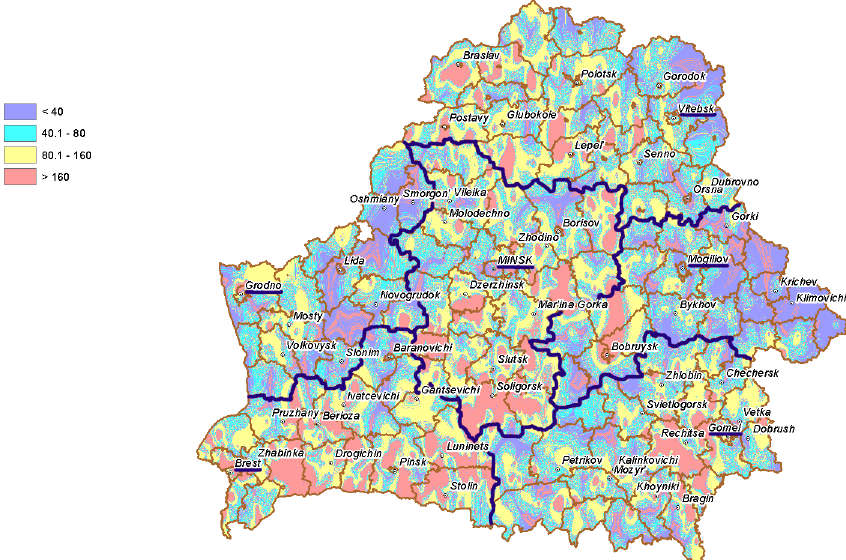
Fig 3. Nitrate concentration (mg/L) in groundwater from open wells in different areas of Belarus in 1988 – 1990. Borders and oblast administrative centers are highlighted in violet.